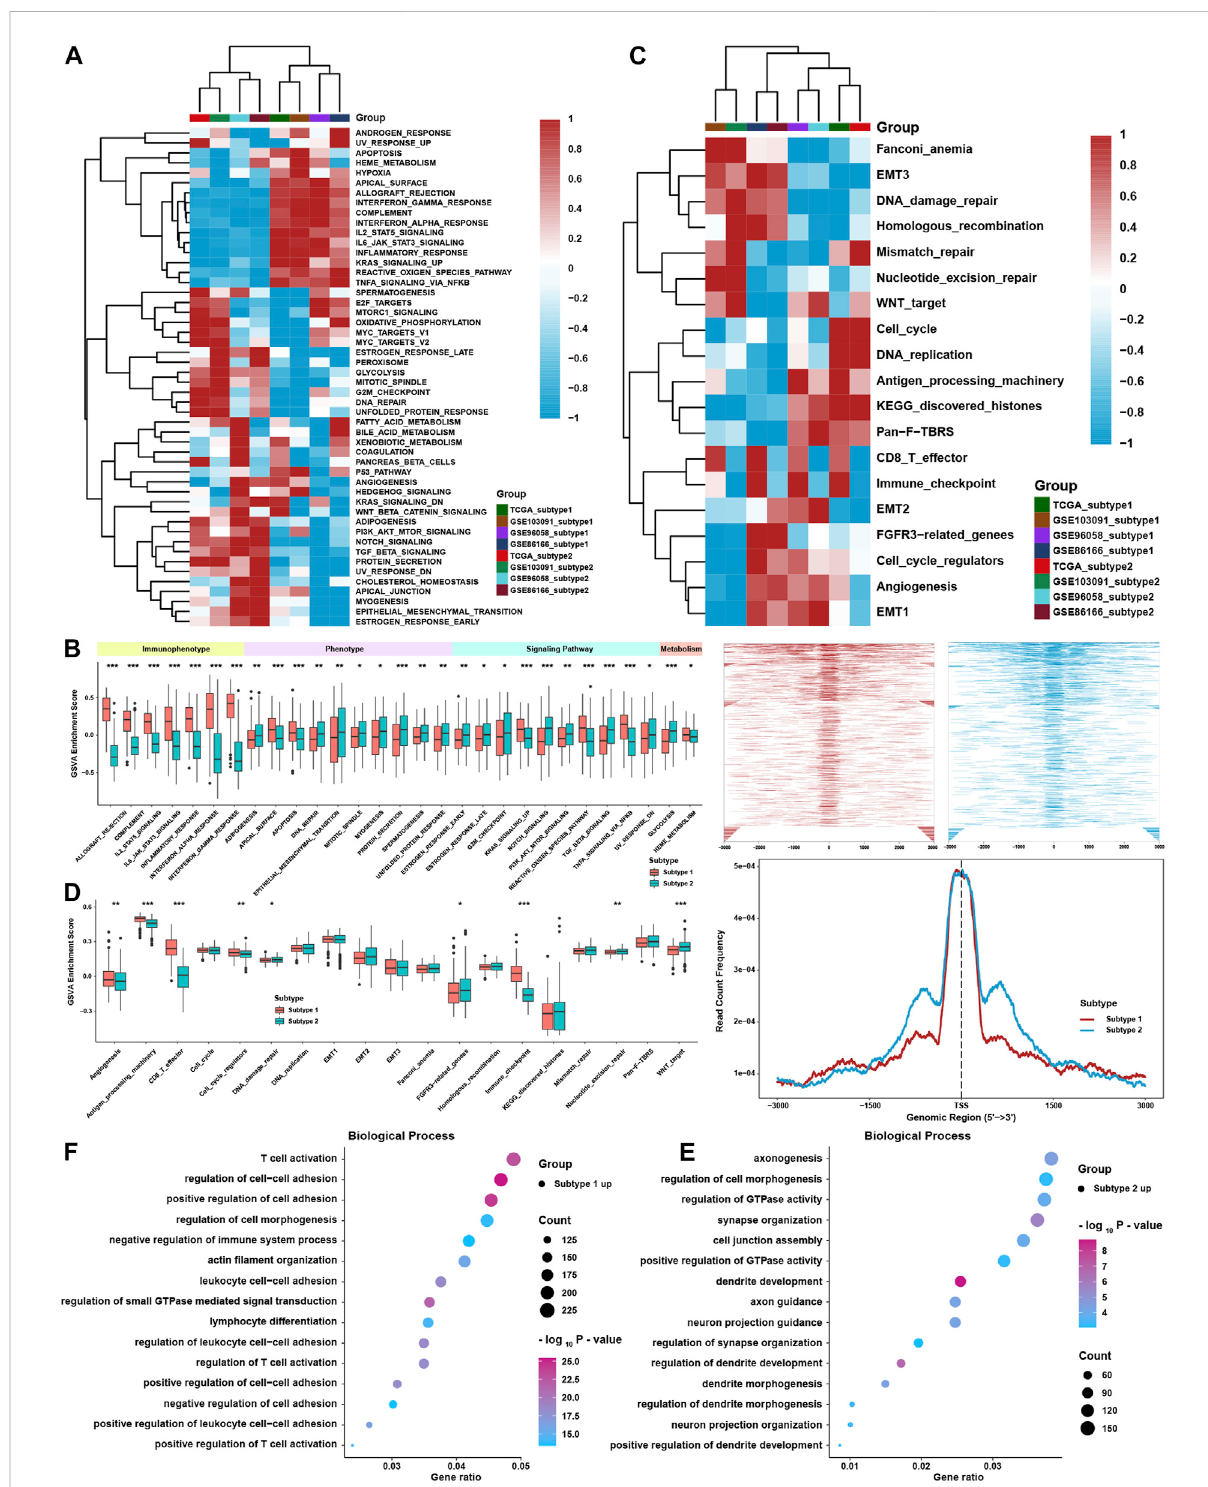
FIGURE 3 Biological function analysis between TME subtypes. (A) Heatmap of the GSVA enrichment score in curated pathways in four TNBC cohorts. (B) Differences in GSVA enrichment scores in curated pathways in the whole TNBC cohort. (C) Heatmap of curated pathways calculated with another pathway signature in four TNBC cohorts. (D) Differences in curated pathways were calculated with another pathway signature in the whole TNBC cohort. (E) Differentially expressed peaks were identi fi ed between the two TME subtypes in TCGA. (F) GO analysis of differentially expressed peaks between two TME subtypes in TCGA. The asterisks represent the statistical p value (* p < 0.05; ** p < 0.01; and *** p <